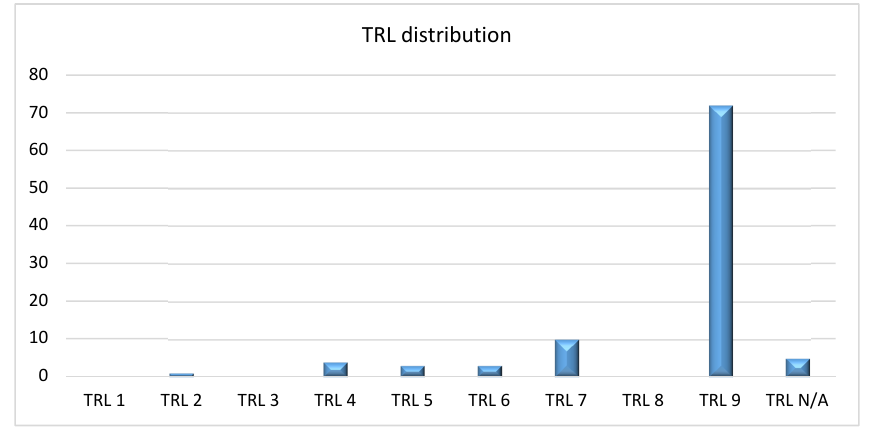
Figure 5. Number of technologies with different technology readiness level (TRL).